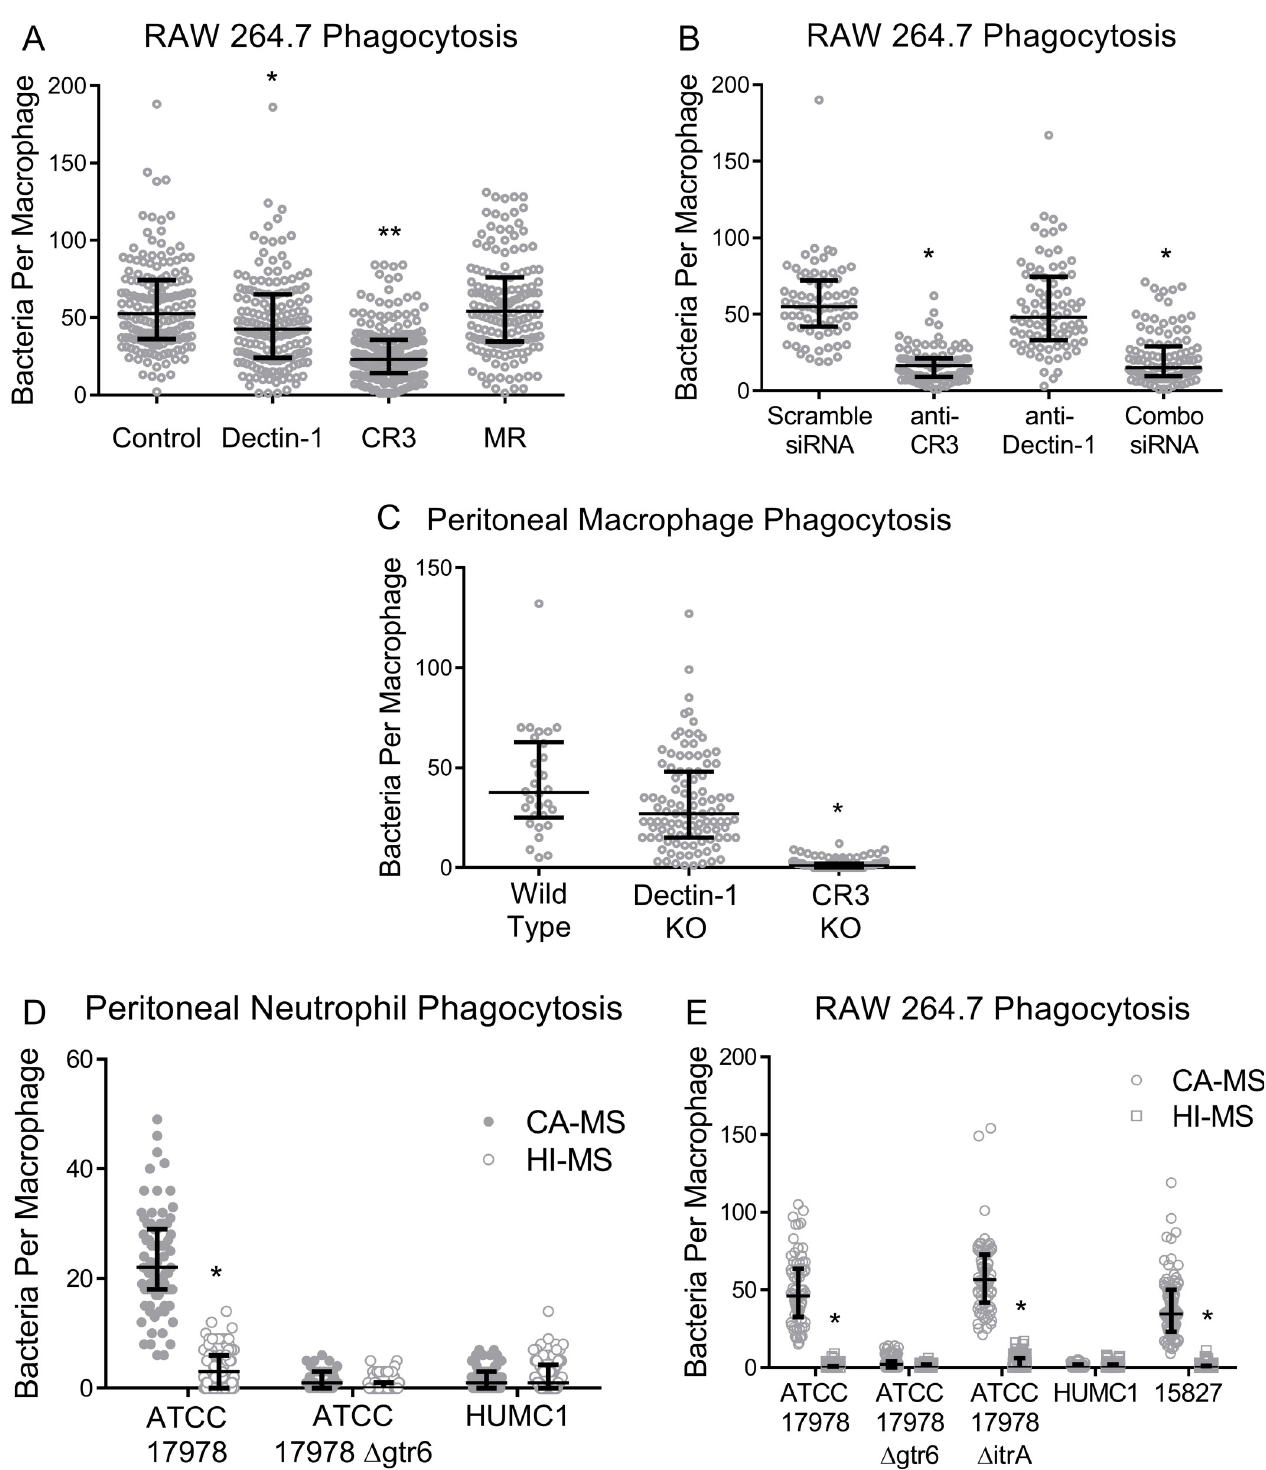
Fig 5. Receptor blockade with siRNA knockdown, antibody neutralization of beta-glucan receptors prior to bacterial uptake, and phagocytosis of bacteria by peritoneal macrophages and neutrophils. (5A) RAW 264.7 cells were pre-incubated with anti-Dectin-1, anti-CR3, anti-MR neutralizing monoclonal antibodies or an isotype control prior to co-incubation with ATCC 17978. � p < 0.0005, �� p < 0.0001 (5B) Knockdown of Dectin-1 and/or CR3 in RAW 264.7 cells followed by incubation with ATCC 17978. � p < 0.0001 (5C) Primary peritoneally-elicited macrophages from C57BL/6 mice followed by phagocytosis assays with ATCC 17978. � p < 0.05, �� p < 0.0001 (5D) Phagocytosis assays of ATCC 17978 with peritoneal neutrophils from wild-type mice with